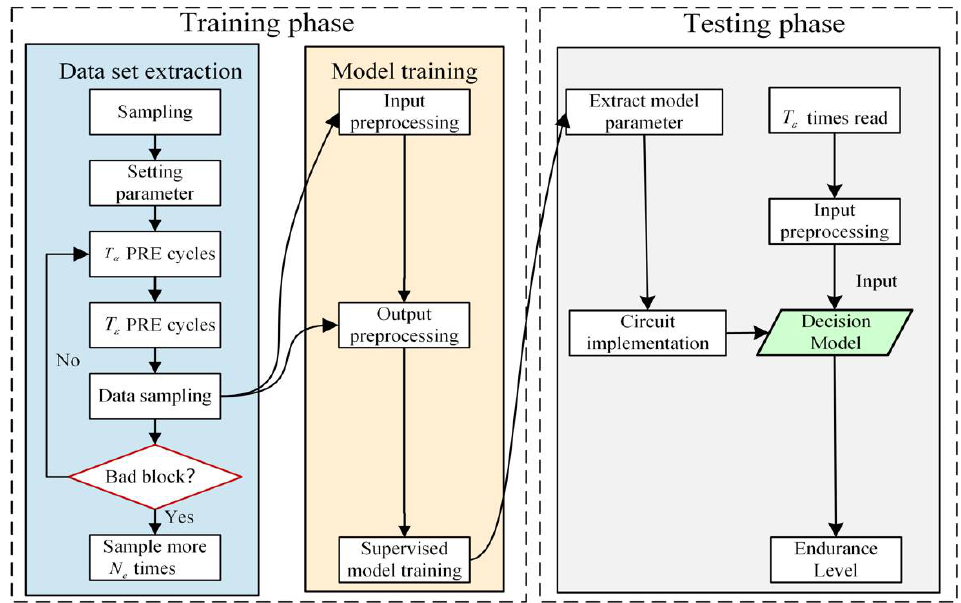
Figure 1. The process of SVM-based endurance prediction method.